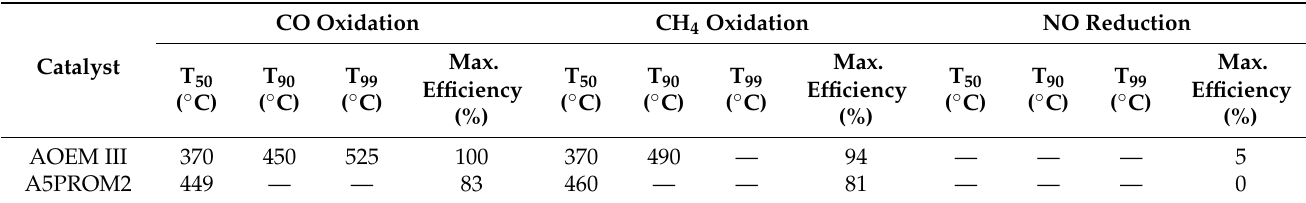
Table 8. Comparison of aged tested catalysts OEM III and 5PROM2 for rich-burn conditions ( λ = 1.03).